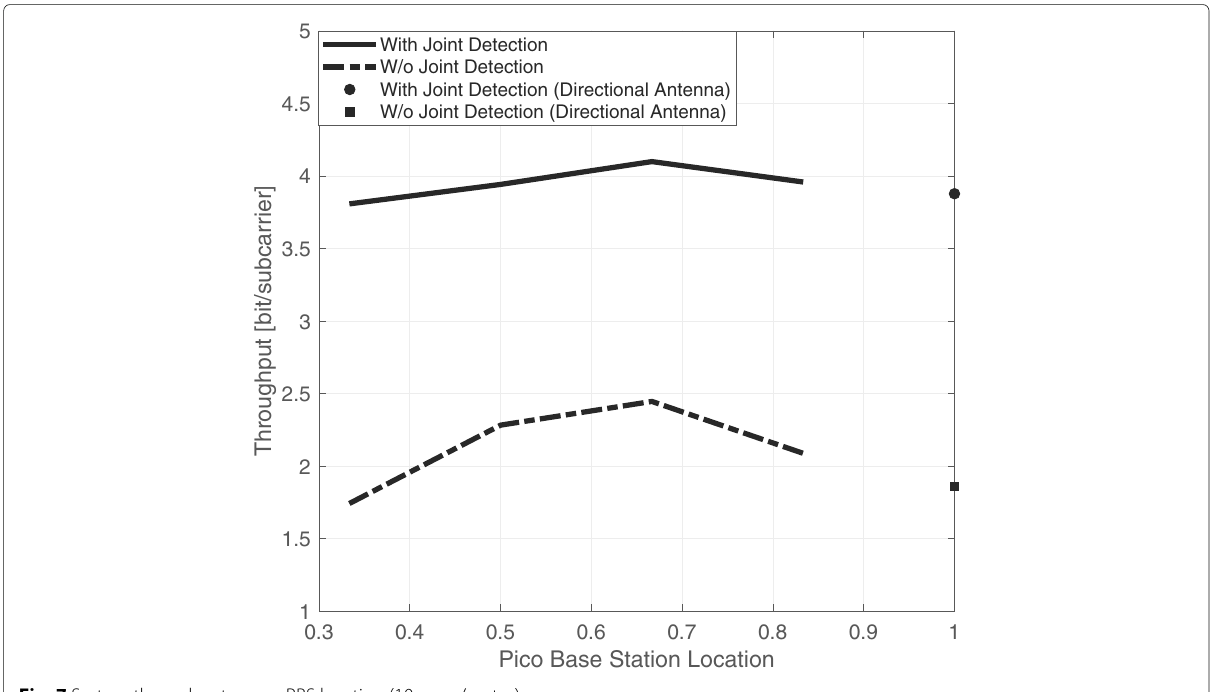
Fig. 7 System throughput versus PBS location (10 users/sector)